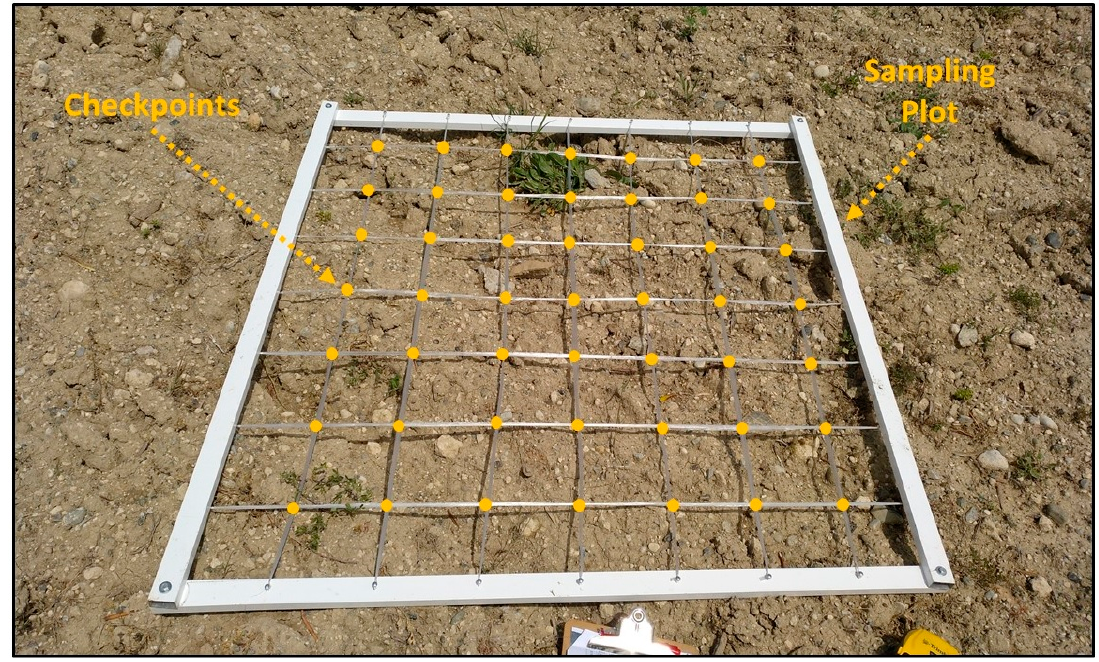
Figure 4. Quadrant-based method for quantifying VGC.